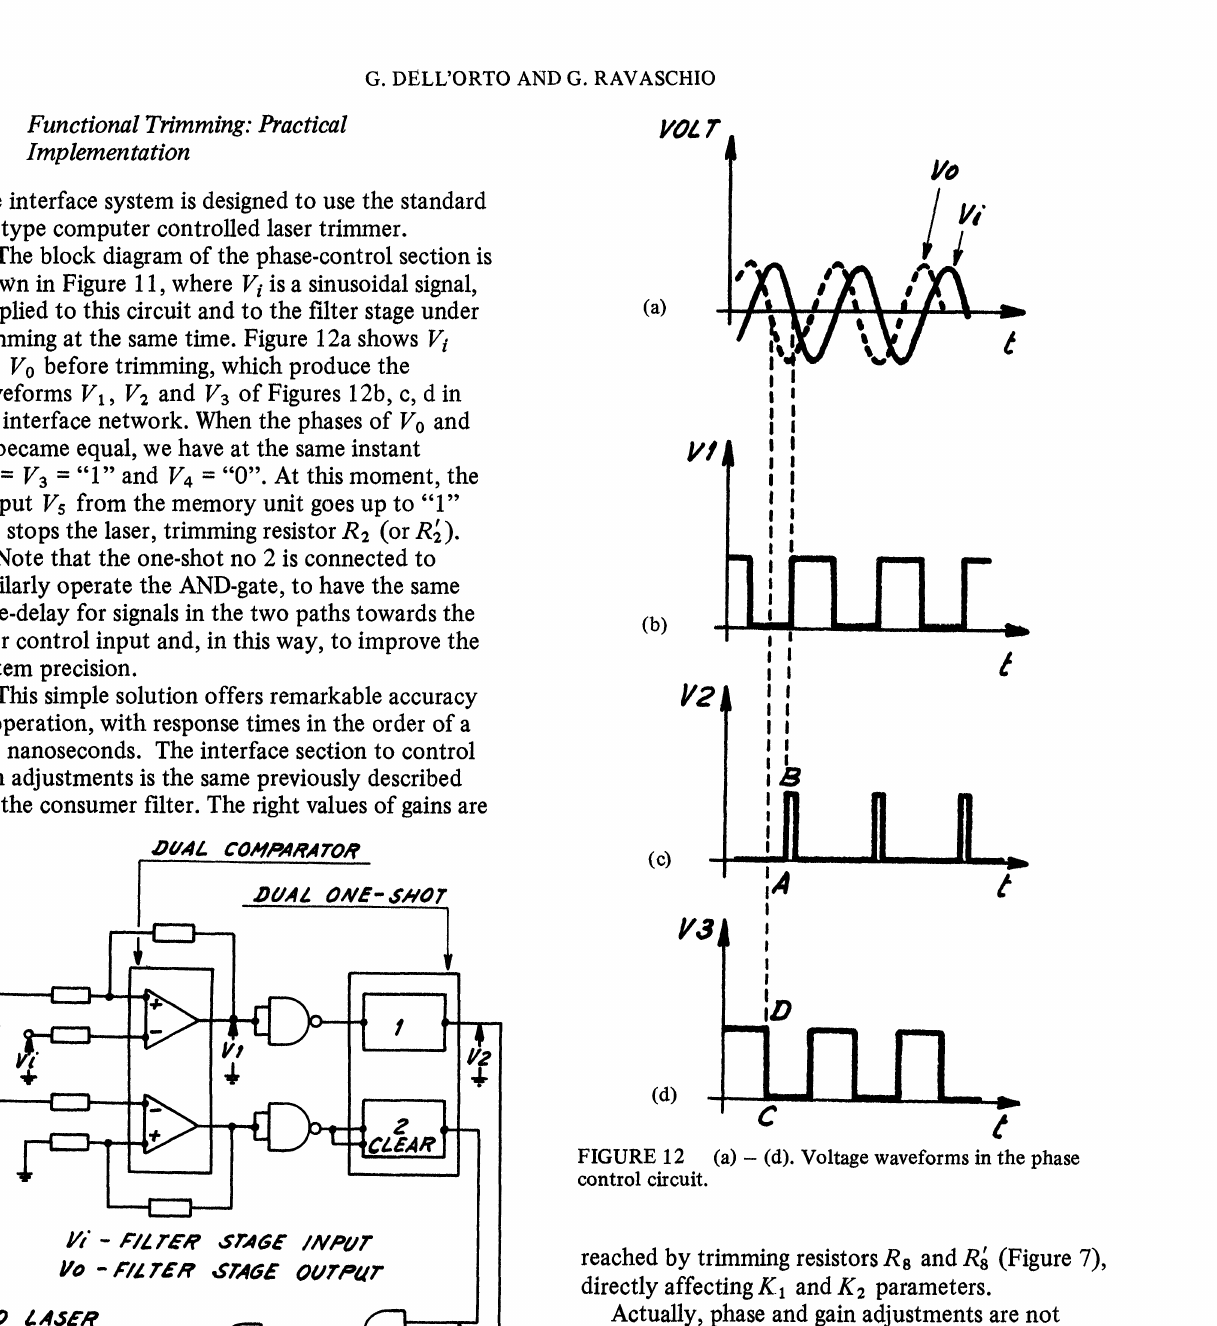
FIGURE 11 Block diagram of phase control